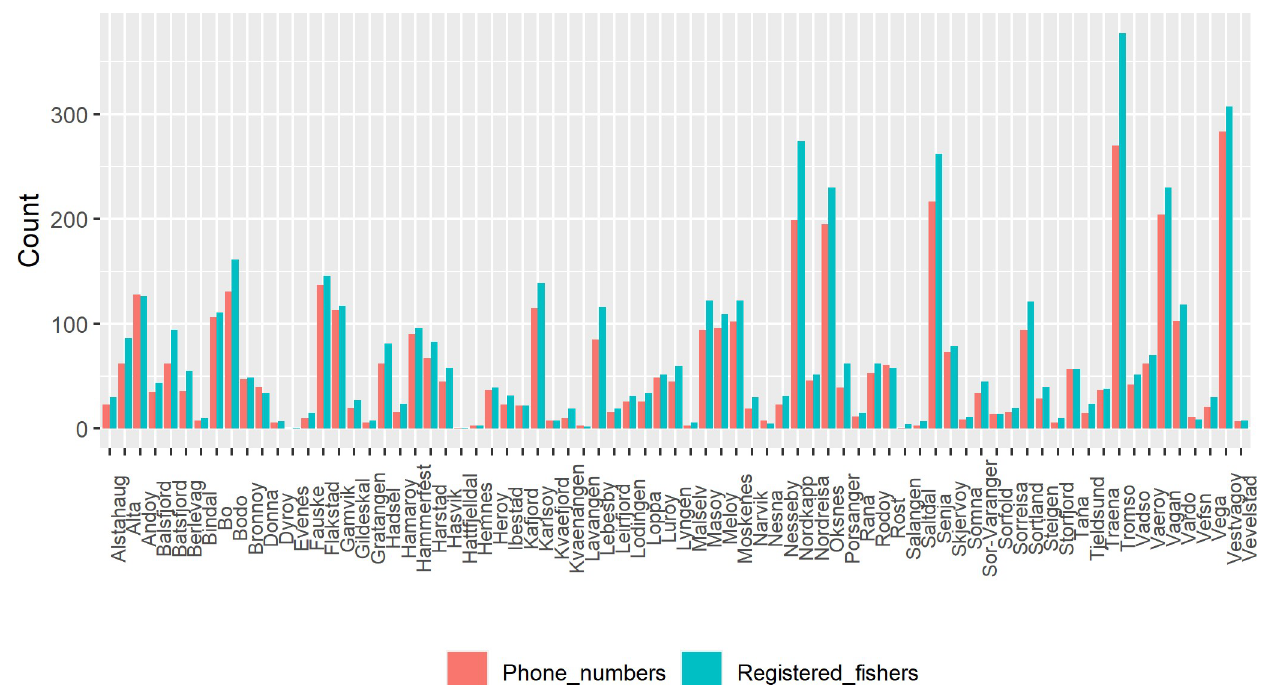
Fig 3. Fisher’s phones: Counts of registered fishers (n = 5151) and fishers’ phone numbers (n = 4278) by municipality.